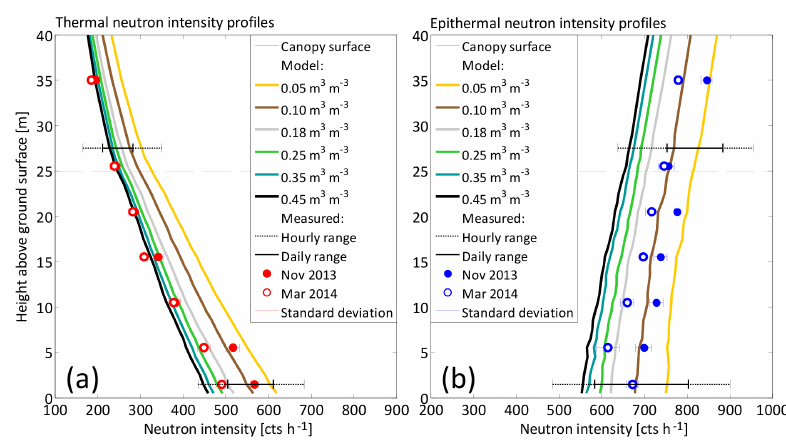
Figure 4. Sensitivity to volumetric soil moisture using model tree trunk, foliage, air. Measured and modeled (a) thermal and (b) epithermal neutron intensity profiles at Gludsted plantation. Hourly and daily ranges of variation of thermal and epithermal neutron intensities at ground and canopy level for the period 2013–2015.